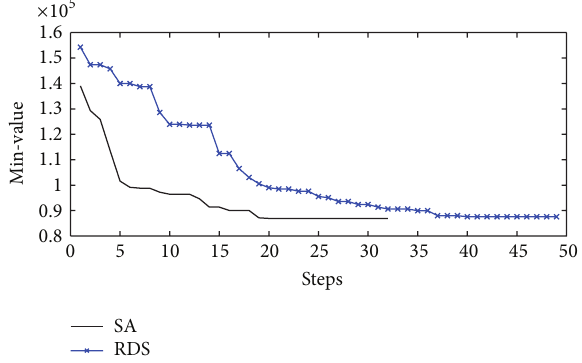
Table 4: 𝑡 0 𝑠 and 𝐶 𝑠 of each transit link.